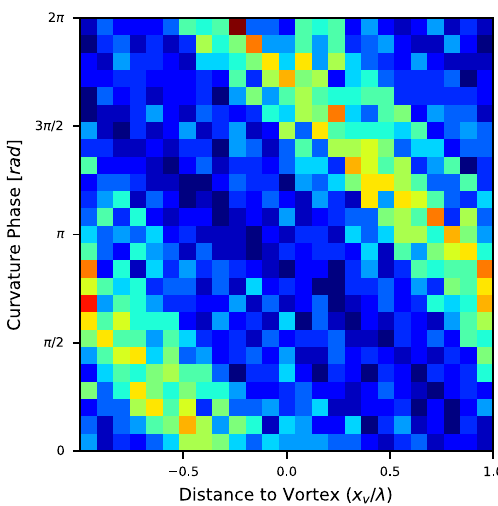
Figure 8. Histogram of extracted fish muscle curvature phase versus non-dimensional distance to vortex. (cid:31) denotes the distance between vortices, while the distance of the fish centre of volume to the next upstream vortex is x v . The extracted phase can been seen to vary close to linearly with distance to vortex. The figure shows data acquired from fish #1 swinging with a foil oscillation frequency of 2